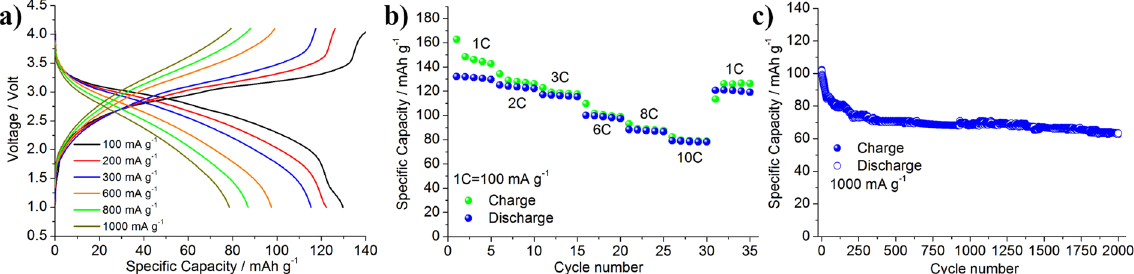
Figure 4. ( a ) Voltage profiles, ( b ) rate performance and ( c ) extended cycling performance at 1000 mAg − 1 of the TiO 2 -B/LP30 + IL/LNMO Li-ion